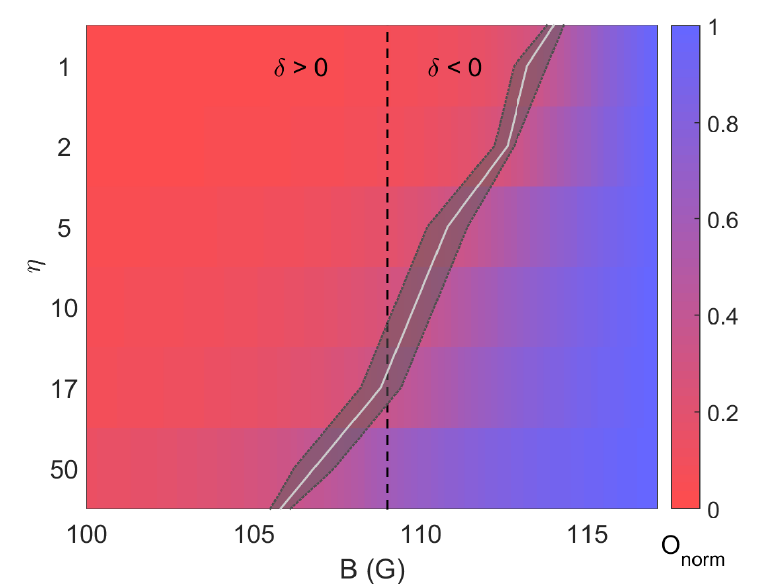
Figure 5. Phase diagram of the miscible–immiscible phase transition for the 23 Na– 39 K mixture under our experimental conditions. The colormap represents the value of the normalized overlap for each combination of η and B . The light gray line sets the phase transition point obtained from the second derivative of the normalized overlap. The condition for an homogeneous system is shown by the black dashed line at B 0 = 109.1